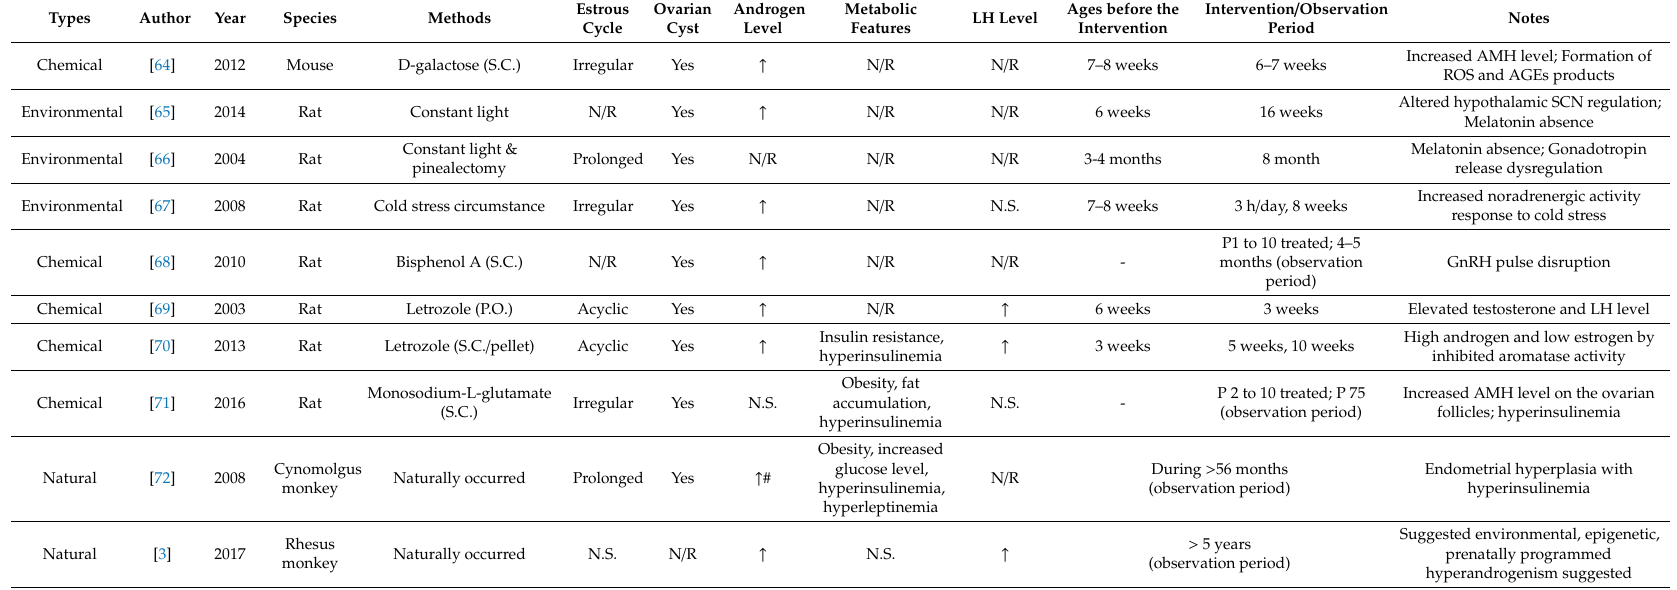
Table 2. Diet- or environmentally or chemically induced animal models including PCOS-like